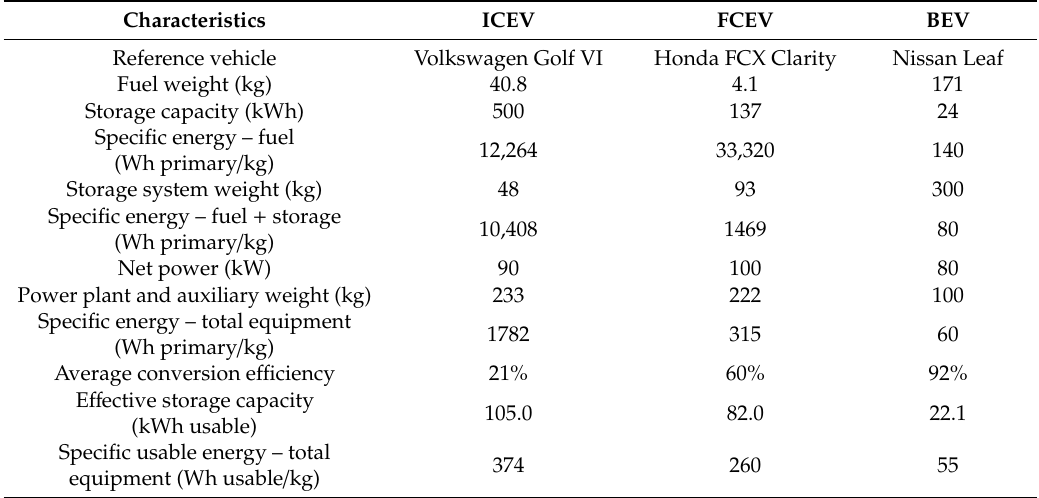
Table 4. Characteristics comparison of ICEVs, fuel cell electric vehicles (FCEVs) and BEVs. Adapted from [11]. *Note that the calculations include the weight of the whole propulsion